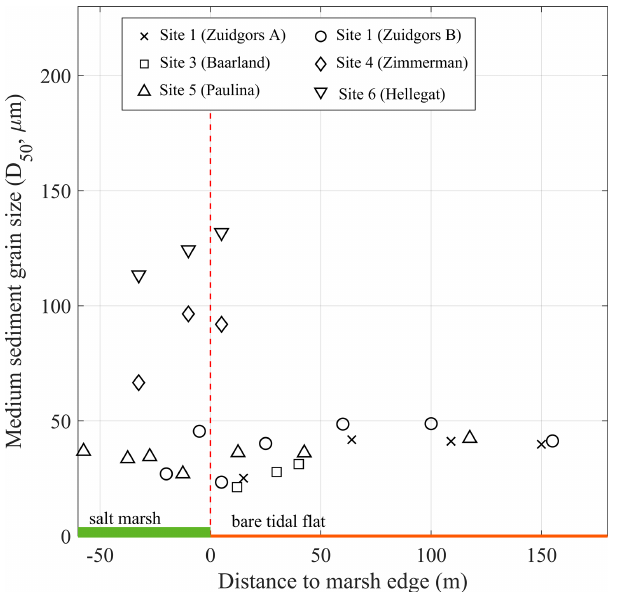
Figure 5. Median grain size of surface sediment ( D 50 ) measured along cross-shore transects of six study sites in the Westerschelde estuary.